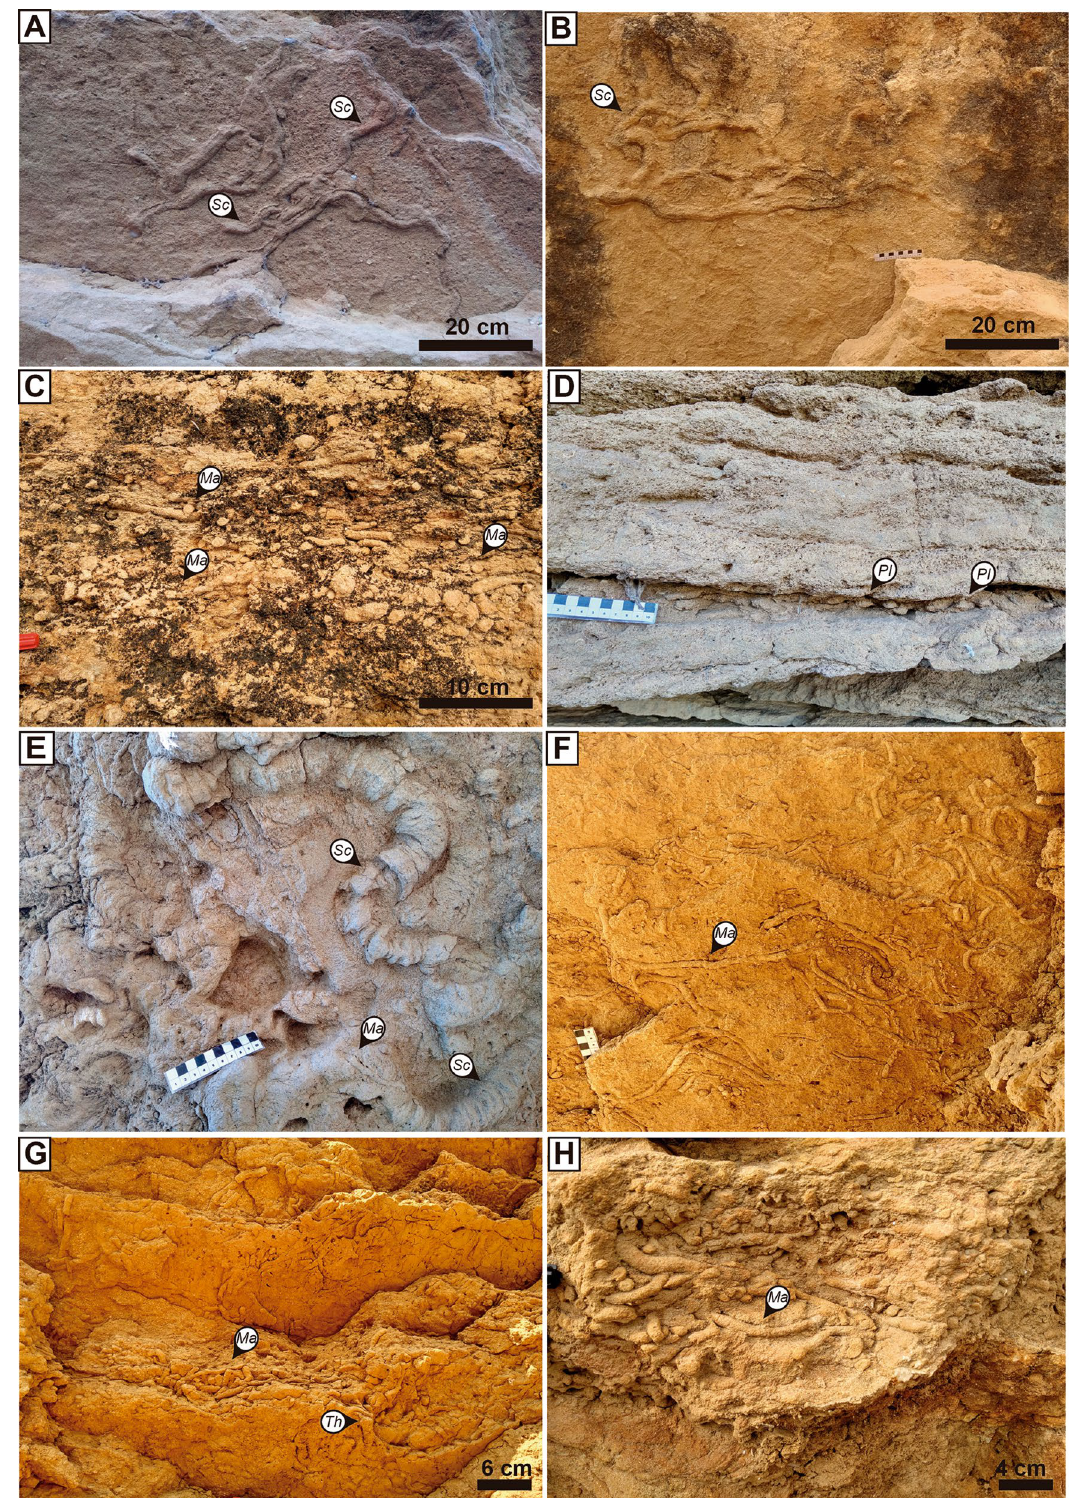
Figure 2. Trace-fossil specimens from the sandy contourite deposits at Sidi Chahed ( A – D ) and Kirmta ( E – H ) outcrops. ( A , B ) Scolicia in the sole of sandy clastic contouritic beds of Sidi Chahed; ( C ) Close-up view of Macaronichnus at Sidi Chahed; ( D ) Planolites within the interbedding of the foresets at Sidi Chahed. ( E ) Scolicia and some Macaronichnus at Kirmta; ( F , G ) Macaronichnus isp. and some Thalassinoides in the sole of sandy clastic contouritic beds at Kirmta; ( H ) Close-up view of Macaronichnus at Kirmta. Macaronichnus ( Ma ), Planolites ( Pl ), Scolicia ( Sc ), and Thalassinoides ( Th